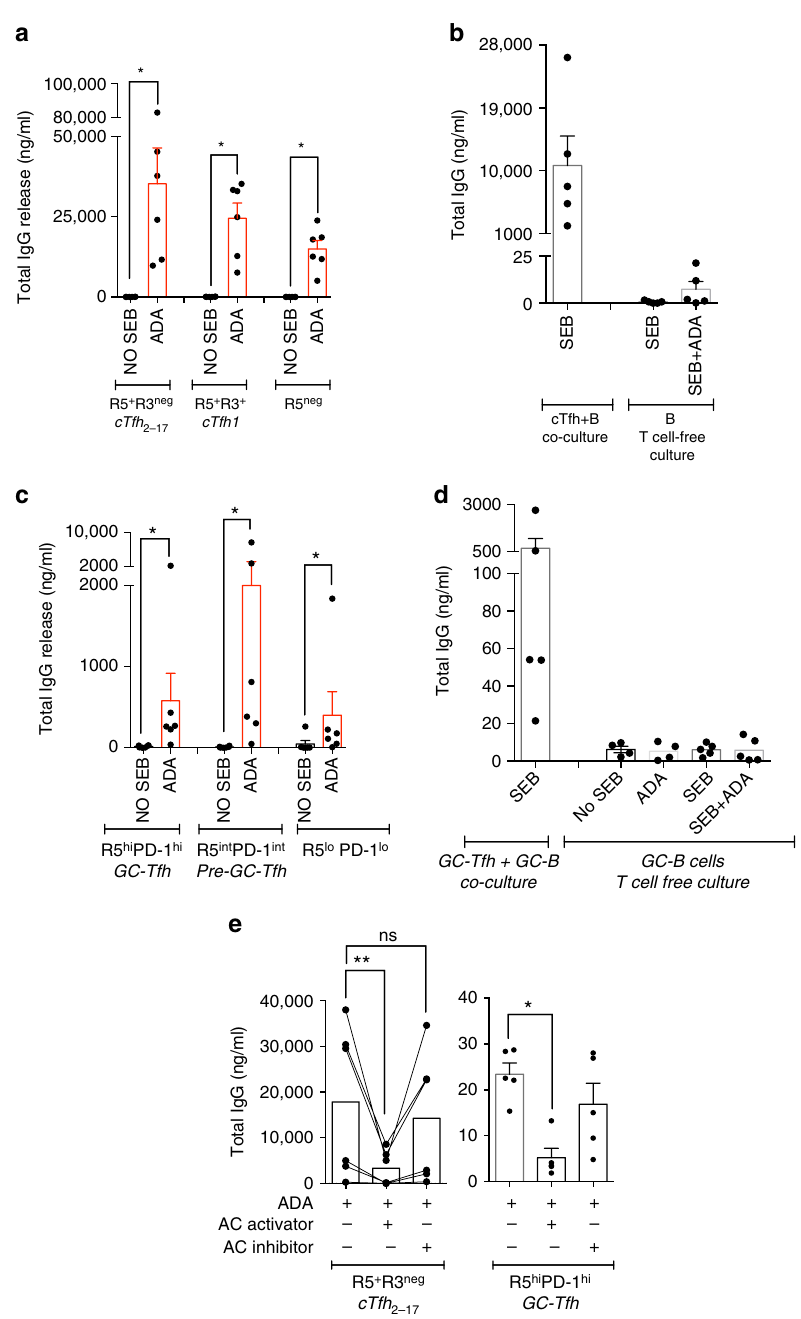
Fig. 5 ADA-mediated helper program is blunted by adenylyl cyclase activation. a Production of IgG in the supernatants of 7-days co-culture of cTfh and non-cTfh with their autologous memory B cells supplemented with exogenous hADA-1. To note, co-culture assays are performed without any other Sag, i.e. SEB ( n = 6 per group, in two-independent experiments). (Wilcoxon, paired, two-tailed non-parametric t -test; * p < 0.05); Mean± SEM). b Comparison of IgG production in the supernatants of 7-day co-culture of cTfh with their autologous memory B cells and T-cell free culture model (only memory B cells) supplemented with hADA-1 and SEB ( n = 5 per group, in two-independent experiments; Mean± SEM). c Production of IgG in the supernatants of 5-day co- culture of GC-Tfh, pre-Tfh and non-Tfh with their autologous GC B cells supplemented with exogenous hADA-1. To note, co-culture assays are performed without any other Sag, i.e. SEB ( n = 6 per group, in two-independent experiments) (Wilcoxon, paired, two-tailed non-parametric t -test; * p < 0.05); Mean ± SEM). d Comparison of IgG production in the supernatants of 5-day co-culture of GC-Tfh with their autologous GC B cells and T-cell free culture model (only GC B cells) supplemented with hADA-1 and SEB ( n = 5 per group, in two-independent experiments; Mean± SEM). e Production of IgG in the supernatants of co-culture assay with cTfh 2-17 (left panel) or GC-Tfh (right panel) performed without adding SEB, but in presence of ADA-1 only, or supplemented with an activator or an inhibitor of adenylyl cyclase (AC) (left panel: n = 6 per group, in two-independent experiments; right panel: n = 5 per group, in two-independent experiment). (ANOVA, paired, two-tailed non-parametric t -test; * p < 0.05, ** p < 0.01; Mean±